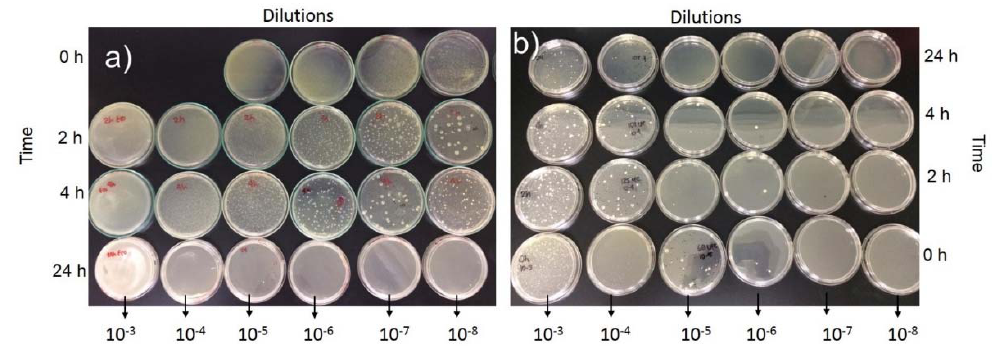
Figure 11. Reduction in the number of viable bacteria over time in the E. coli agar for ( a ) GP and ( b ) GP ‐ G.